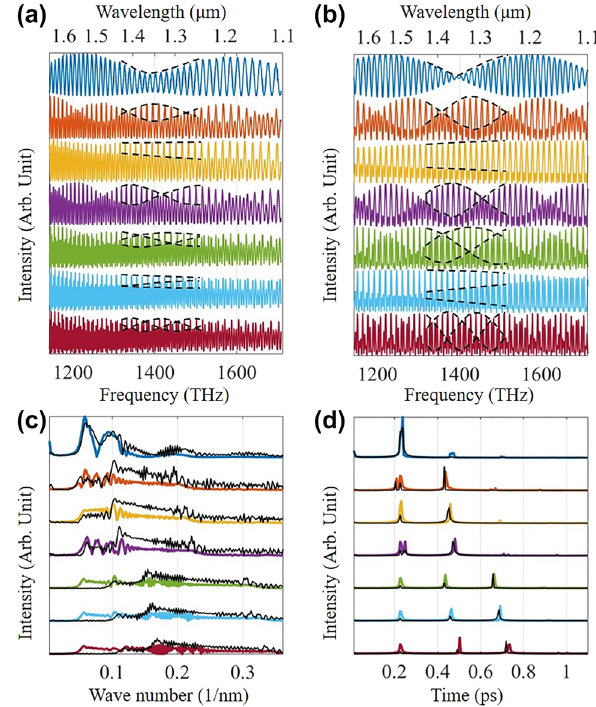
Figure 2: Typical reflections with envelope modulation in (a)experimentsand(b)theory.Fromtoptobottom,there fl ectionsin (a) are the air resonator length 2.70, 65.20, 71.45, 77.70, 133.95, 141.45, and 151.45 μ m. The re fl ections in (b) are the length of air resonator 2.70, 63.10, 69.58, 75.20, 131.00, 139.10, and 151.45 μ m. The dashed curves guide the eye toward the modulation. Fourier transform shows the mode components in the reciprocal space of (c) wavelength and (d) frequency. The colored and black curves are the theoretical and experimental